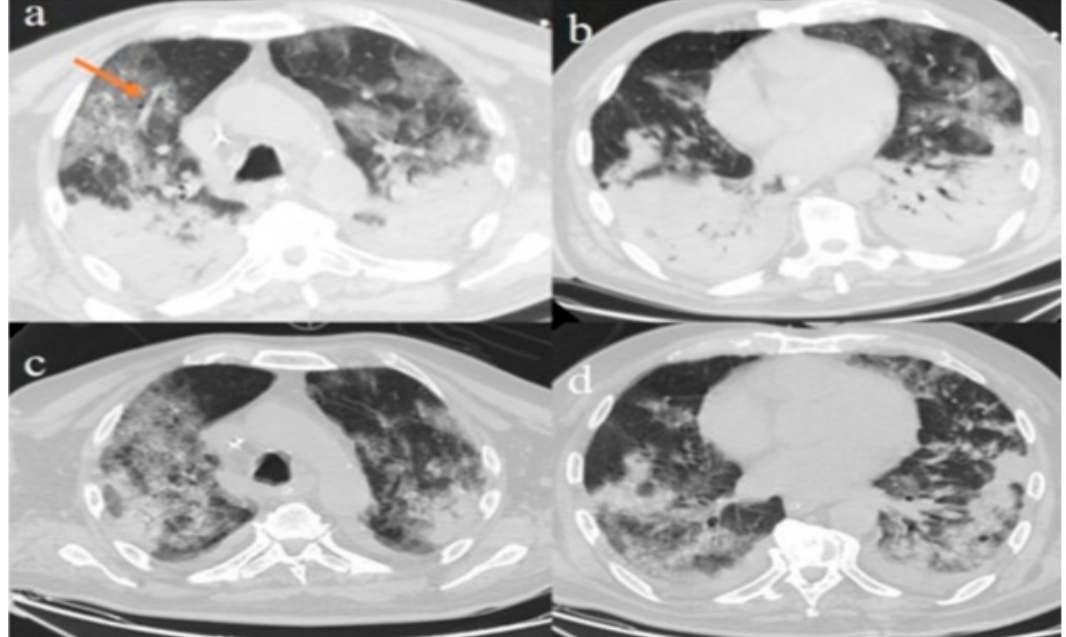
Figure 2. Chest CT of Case 2. Lung window (W: 1500 UH, L: − 400 UH) of chest CT scan: ground-glass opacities in a crazy paving pattern with consolidations in the superior lobes with more posterior and peripheral distributions associated with severe consolidations in the inferior lobes ( a , b ) and vascular enlargement (orange arrow) ( a ); reduction of consolidations in the superior ( c ) and inferior lobes ( d ) after tocilizumab therapy.